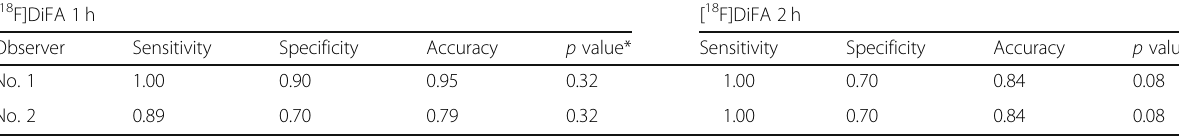
Table 7 Diagnostic accuracy of [ 18 F]DiFA PET/CT for the detection of tumor